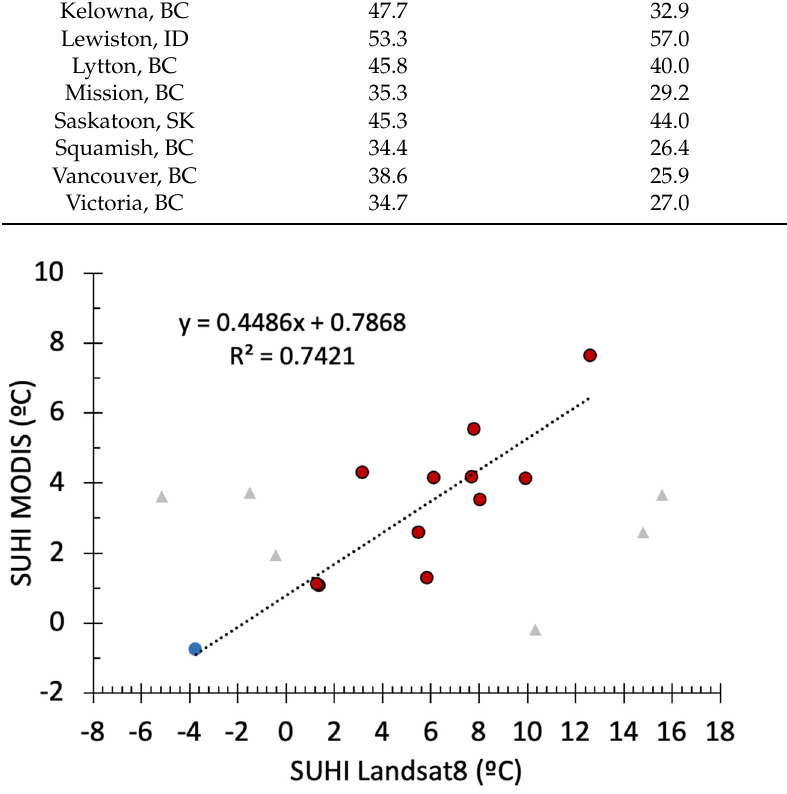
Figure 4. Comparison between daytime SUHI intensities estimated from MODIS and Landsat-8 imagery for the subset of 18 cities (see also Table S3). Triangle symbols indicate outliers that were not considered in the linear fit.